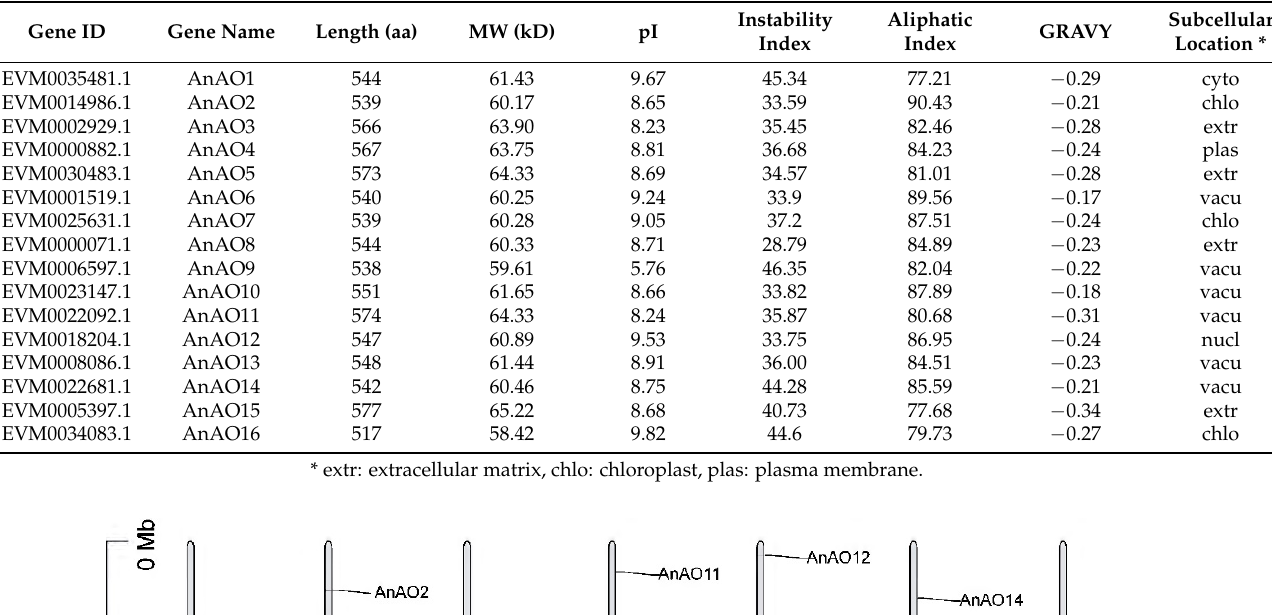
Table 1. Characterization of predicted AOs in A. nanus .